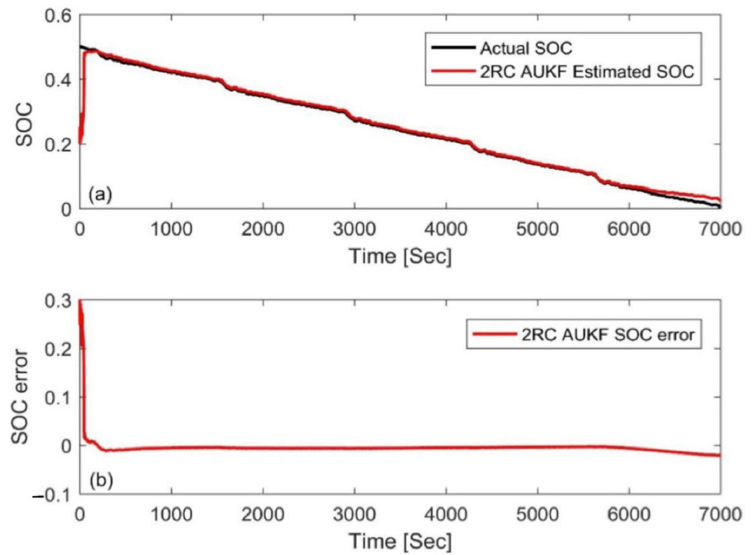
Figure 9. Estimation results by the AUKF at an initial SOC value of 20%. ( a ) SOC estimation comparison curve; ( b ) SOC estimation error.